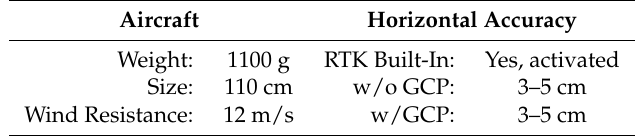
Table 1. Manufacturer technical specifications for the eBee Plus platform